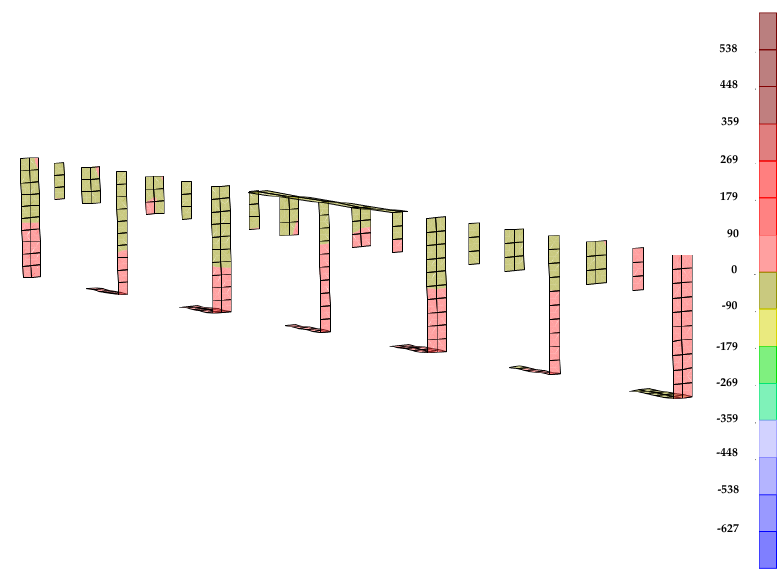
Figure 6. The highest displacement and deformation under the load [10]. There are higher tensile stresses directly under the load with the largest value equal to 71 MPa (10.3 ksi) at 6.35 mm (0.25 in) from the bottom fiber of the fourth main bearing bar at the midspan (Figure 7). Note that the fourth bearing bar is directly beneath a tire patch. However, the highest tensile stress value at 6.35 mm (0.25 in) from the bottom fiber close to the interior support was 16 MPa (2.3 ksi). In addition, there are compressive stresses at the top fibers for the midspan and the interior support of − 31 and − 7 MPa ( − 4.5 and − 1 ksi), respectively.